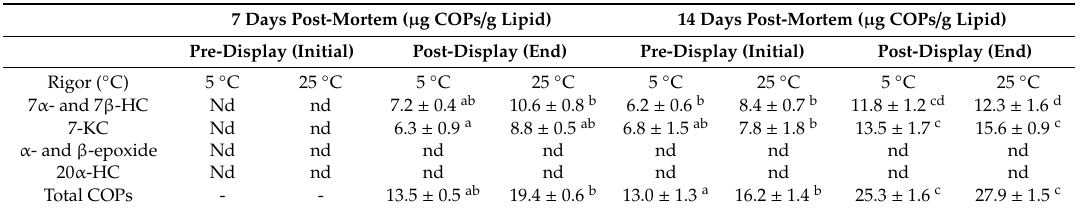
Table 1. COPs identified in hot boned beef SM muscle aged 7 and 14 days (with rigor temperatures 5 ◦ C and 25 ◦ C) (initial) and 7 days of display time (end). 7 Days Post-Mortem ( µ g COPs / g Lipid) 14 Days Post-Mortem ( µ g COPs / g Lipid) Pre-Display (Initial) Post-Display (End) Pre-Display (Initial) Post-Display (End) Rigor ( ◦